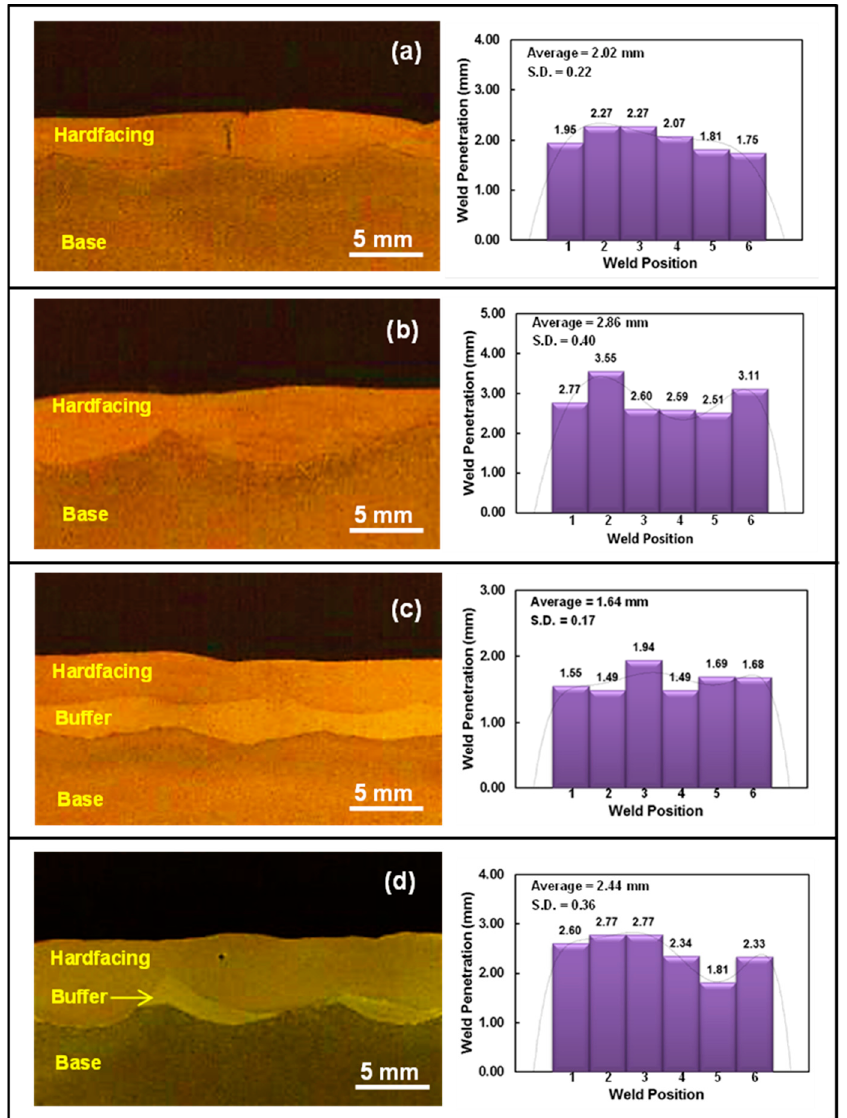
Figure 2. Macroscopic results and weld penetration profiles of hardfacing welded specimens: ( a ) S1, ( b ) S2, ( c ) H1, and ( d ) H2.